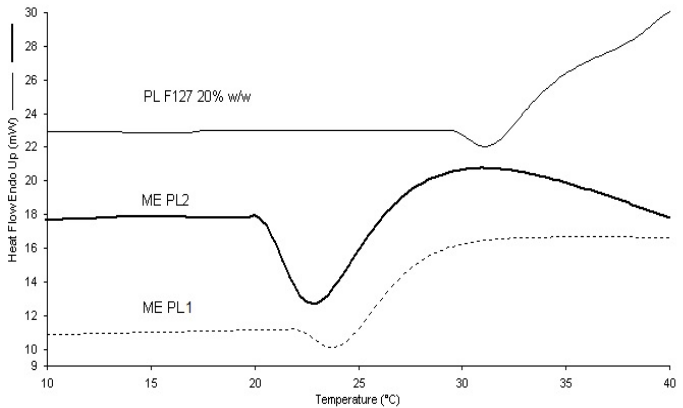
Figure 5. Thermograms of PL with (PL2) and without (PL1) BVZ, compared to thermogram of Pluronic ® F127 solution.